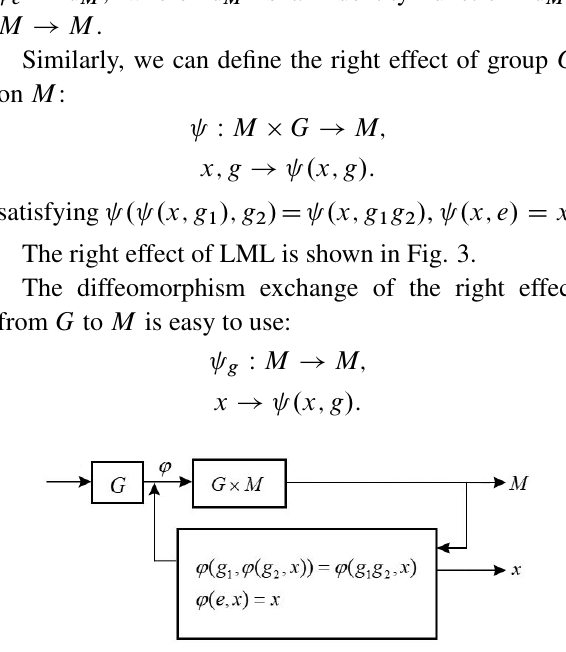
Fig. 2 Left effect model of Lie group machine learning.